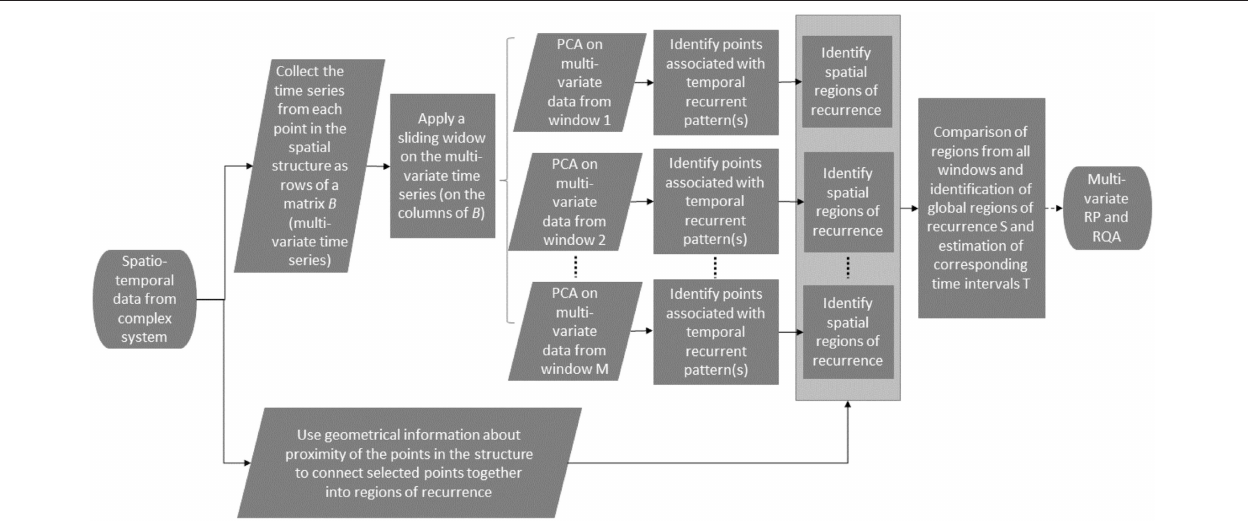
FIGURE 1 | Schematic of the framework. Briefly, the time series associated with each point in the geometric structure are collected into a matrix B , which can be seen as a multi-variate time series. A sliding window is applied over the multi-variate time series, and each window is decomposed by means of PCA. The information from the PCA decomposition is used to retrieve the points in the structure associated with a temporal recurrent pattern. The geometric information about proximity of the points is then used to cluster together points of recurrence which are next to each other, and identify spatial regions of recurrence. Finally, the information from all windows is used to create global regions of recurrence and estimate their time intervals (spatio-temporal